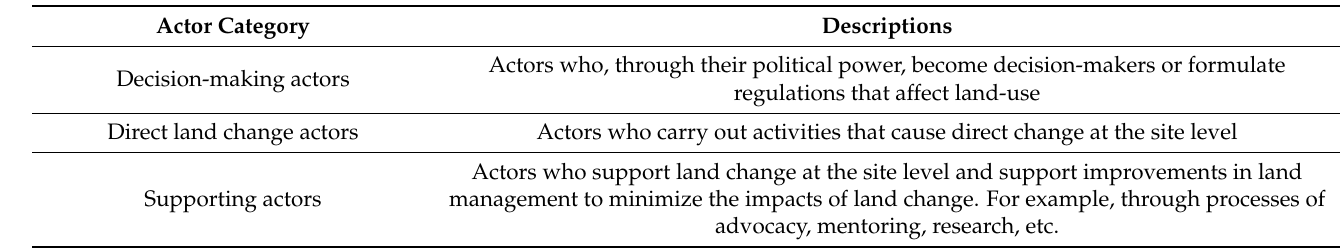
Table A4. Actors related to land change